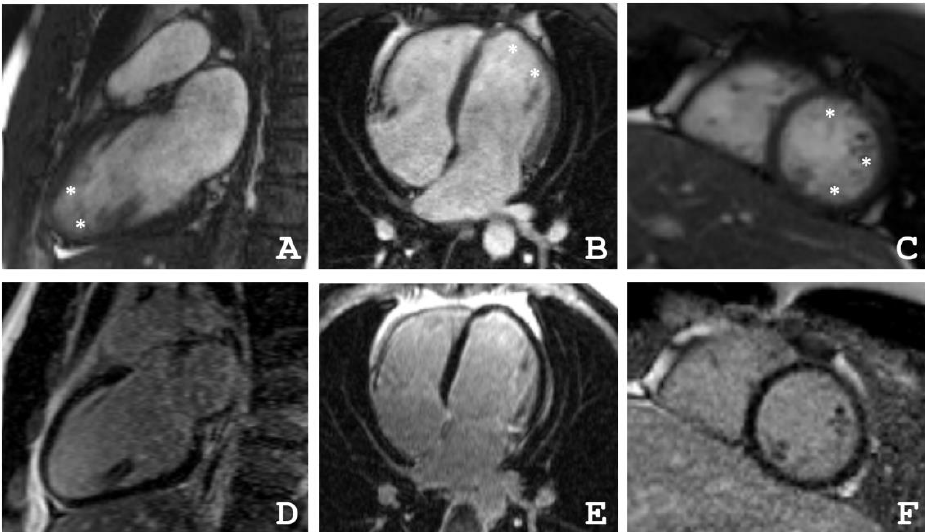
Figure 4. ( A – C ) Cardiac magnetic resonance imaging of the proband’s brother (III-2) in movie mode, SSFP sequence: ( A ) long axis 2-chamber projection, ( B ) long axis 4-chamber projection, ( C ) short axis at the level of apical segments, * indicates the layer of non-compacted myocardium, ( D – F ) delayed contrast. Inversion recovery sequence with suppression of the signal from the myocardium. There were no areas of contrast, which indicates the absence of areas of intra-myocardial fibrosis, scarring, and inflammatory myocardial damage.